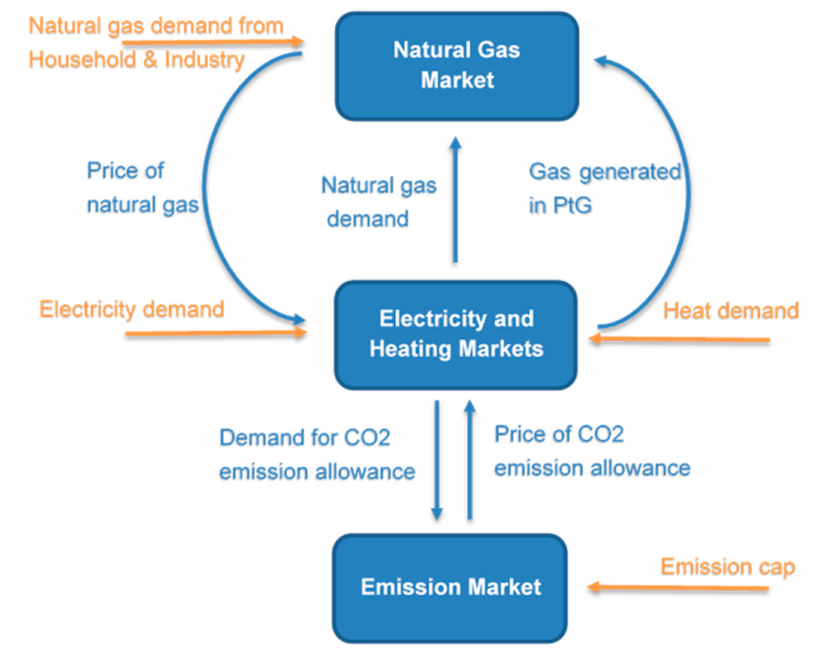
Figure 1. Structure of